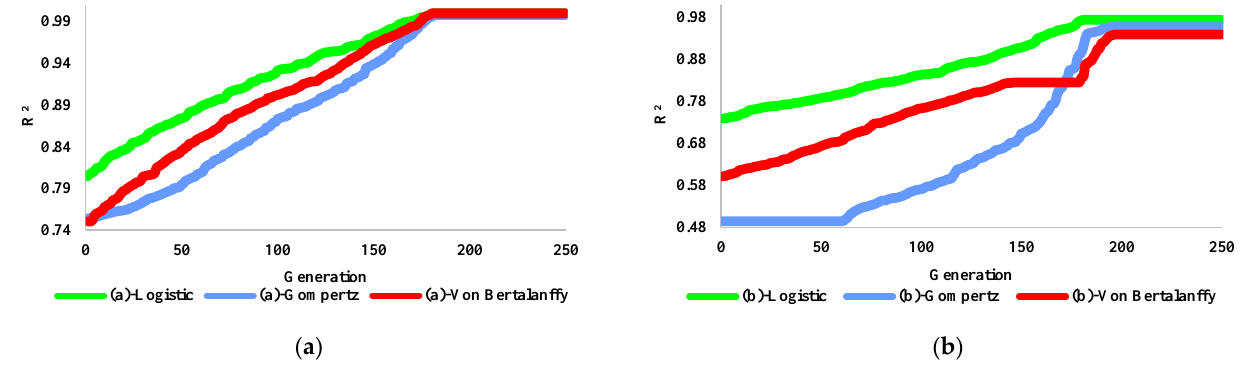
Figure 4. Example of the data convergence curves of determination coefficient models for optimiza- tion process (R²) for broilers ( a ) and pigs ( b ).